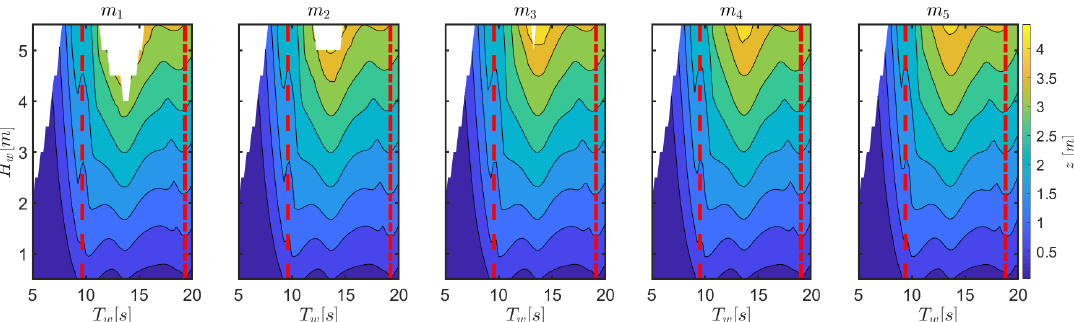
Figure 11. Amplitude of the heave response for different mooring configurations, as tabulated in Table 3. For a fair comparison, the same color bar applies to all plots. The dashed and dash-dotted red lines correspond to T w = 1 T n ,5 and T w = T n ,5 , respectively. 2